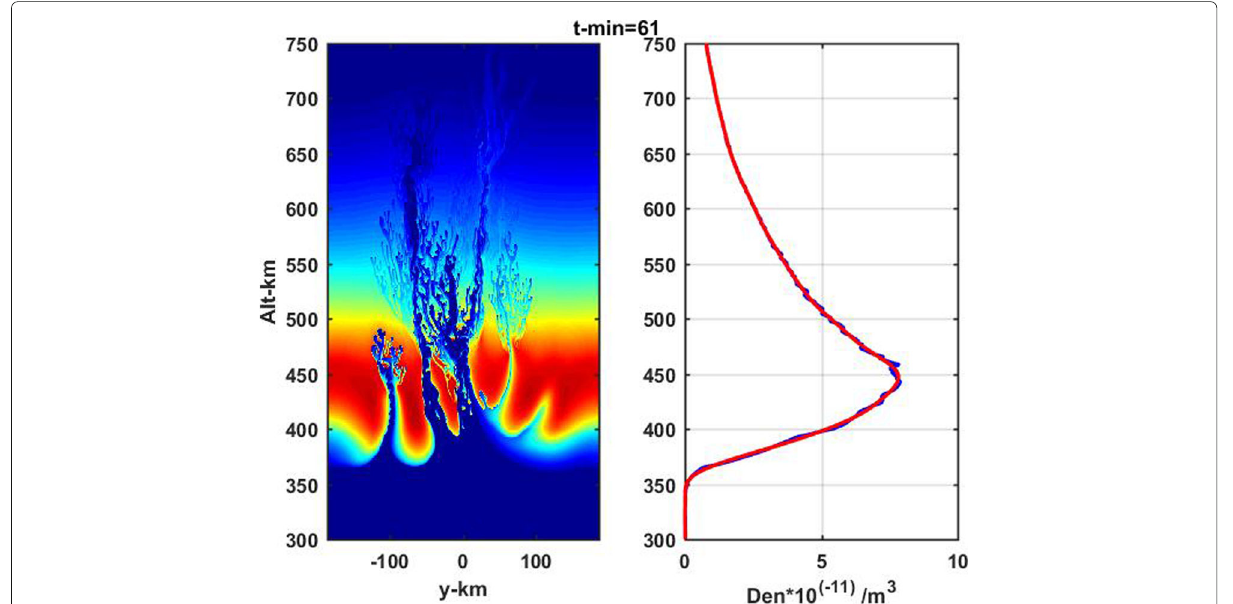
Fig. 3 The left frame shows the equatorial plane structure at 1 h. The right frame shows the path-integrated density (blue) with a smoothed profile overlaid